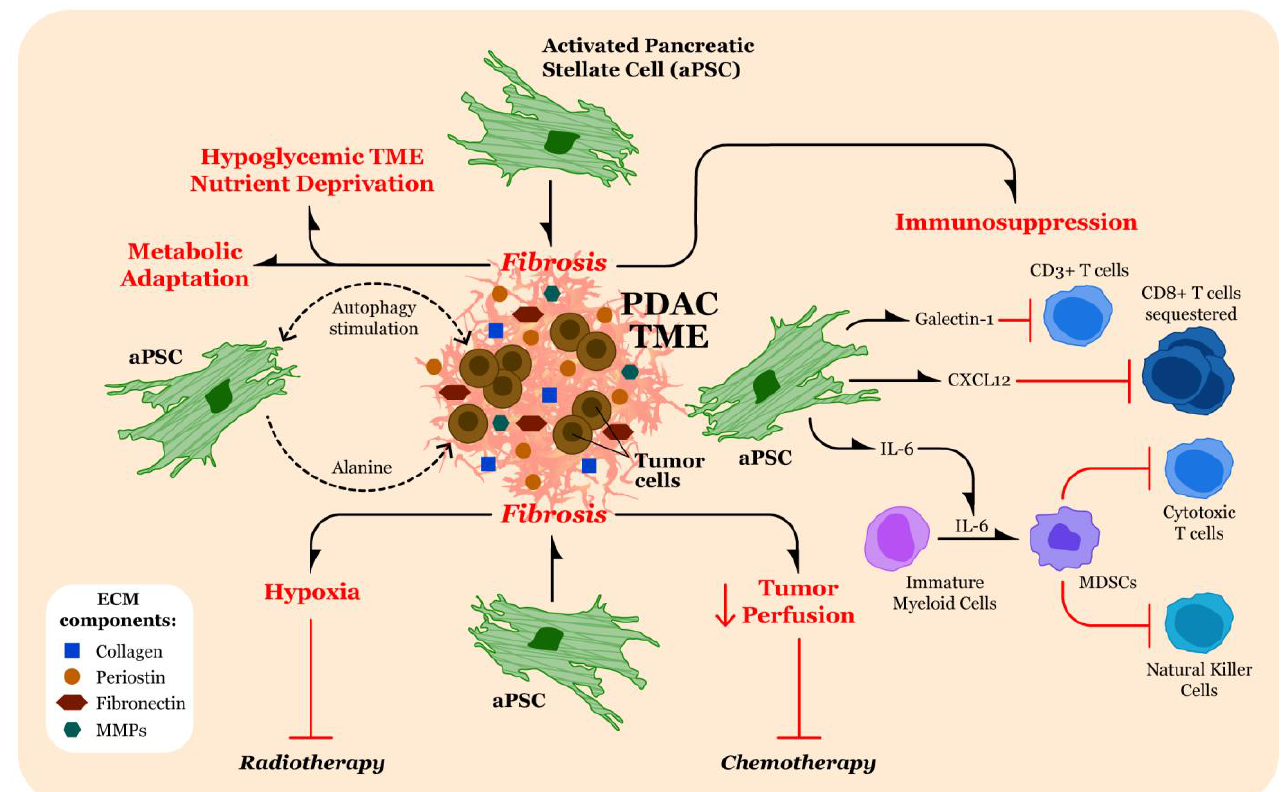
Figure 2. Contribution of extracellular matrix (ECM)/fibrosis to pancreatic ductal adenocarcinoma (PDAC) pathogenesis. Activated pancreatic stellate cells (aPSC) release significant quantities of ECM components, including collagen, periostin, fibronectin, and matrix metalloproteinases (MMPs) into the PDAC tumor microenvironment (TME) that contribute to fibrosis. The fibrotic PDAC TME results in several pathogenic effects (noted in red text). The abundance of fibrotic material in the PDAC TME can result in hypoxia and decreased tumor perfusion, which inhibit the therapeutic effects of radiotherapy and chemotherapy, respectively. Moreover, fibrosis can lead to hypoglycemia and nutrient deprivation in the TME. In response to nutrient deprivation, PDAC tumor cells metabolically adapt by stimulating autophagy in aPSCs, leading to release of alanine from aPSCs, which is then used for fuel by the PDAC tumor cells. The aPSCs may also stimulate autophagy in PDAC tumor cells. Immunosuppression in the TME is established in part by the release of galectin-1 and CXCL12 by aPSCs, inhibiting CD3 + T cells and sequestering CD8 + T cells, respectively. Additionally, release of interleukin-6 (IL-6) by aPSCs results in conversion of immature myeloid cells to myeloid-derived suppressor cells (MDSCs), which then inhibit infiltration by cytotoxic T cells and natural killer cells.